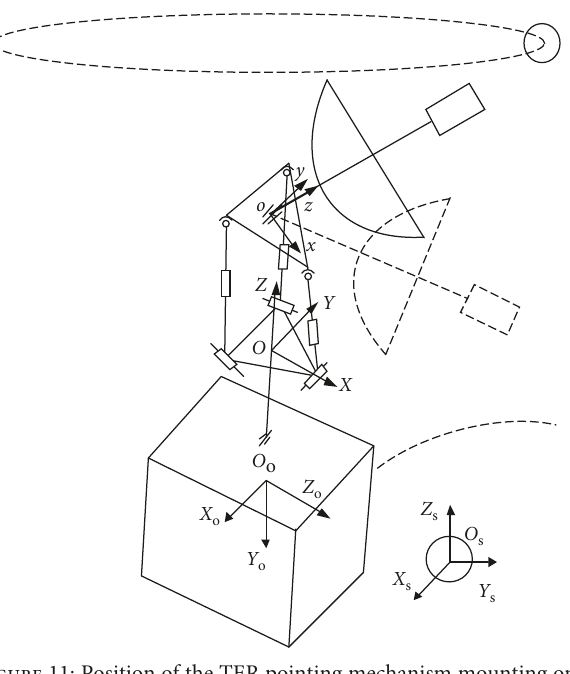
Figure 11: Position of the TER pointing mechanism mounting on the